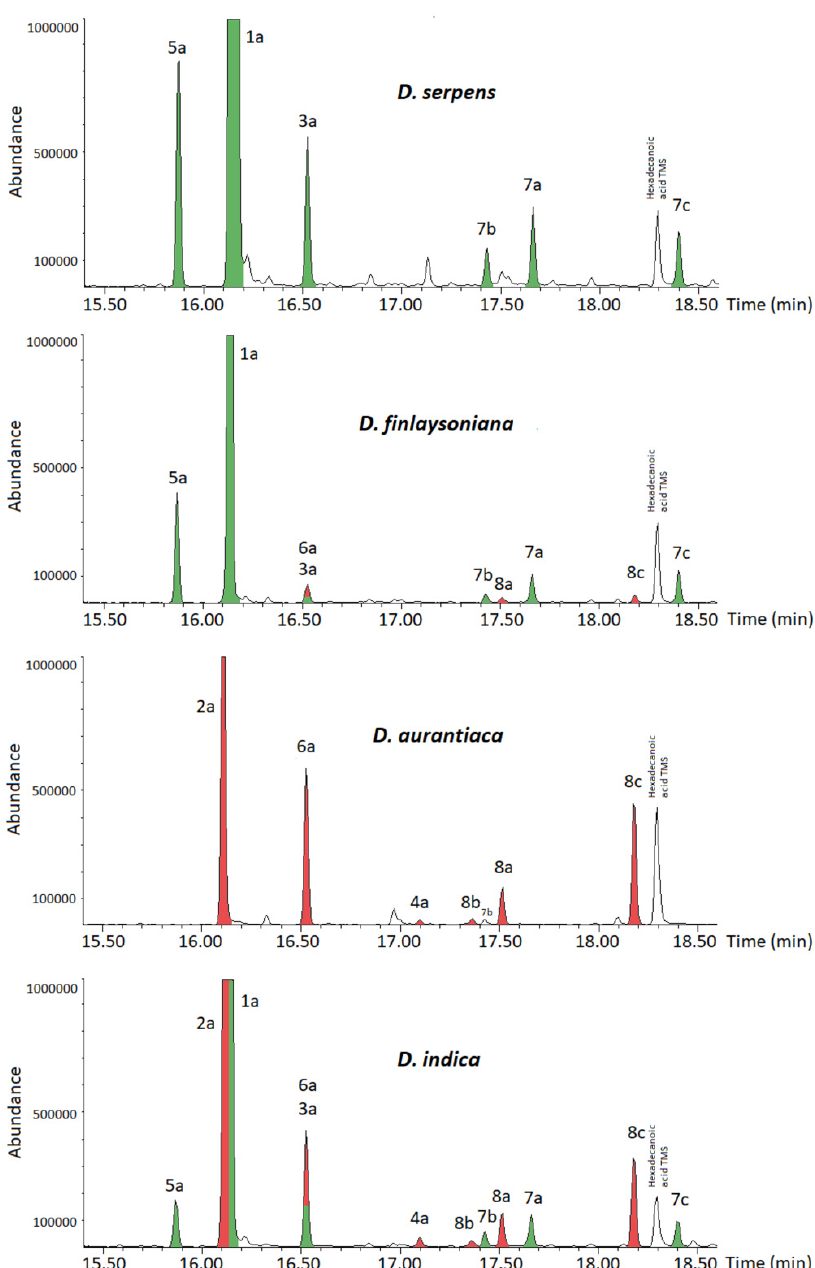
Figure 1. GC-MS TIC chromatograms of TMS-derivatives of metabolites in petroleum ether extracts of four sundew species. Metabolites of the 2-methyl series are marked in green, and those of the 7-methyl series are marked red.